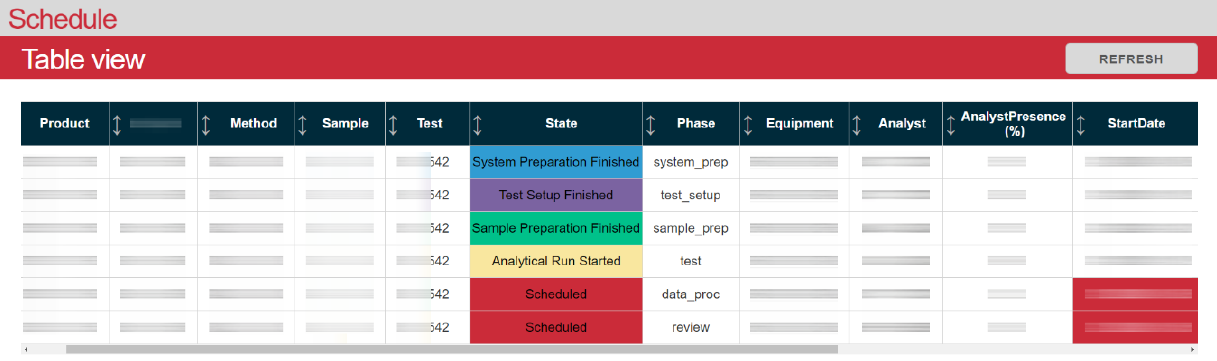
Figure 9. Table view with the task states from a test.